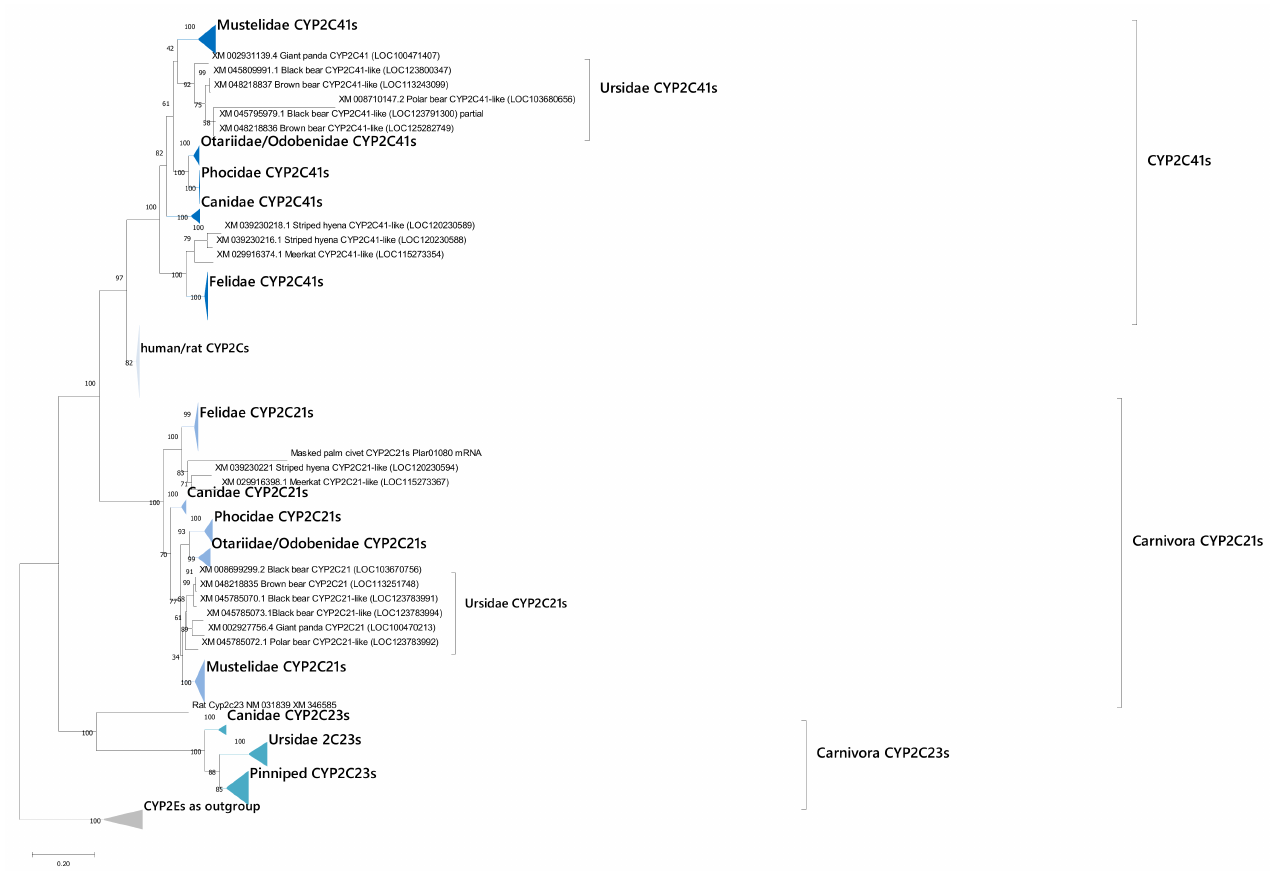
Figure 4. A phylogenetic tree of CYP2Cs sequences in humans and carnivorans. Gene sequences of protein-coding regions for each isozyme were analyzed. The numbers next to the branches indicate the number of occurrences per 100 bootstrap replicates. Genes and clades are tentatively labeled with Carnivoran CYPs examined in this article. Clades of CYP2C41s, CYP2C21s, and Carnivora 2C23s are shown as differently colored triangles. CYP2Es are shown as an